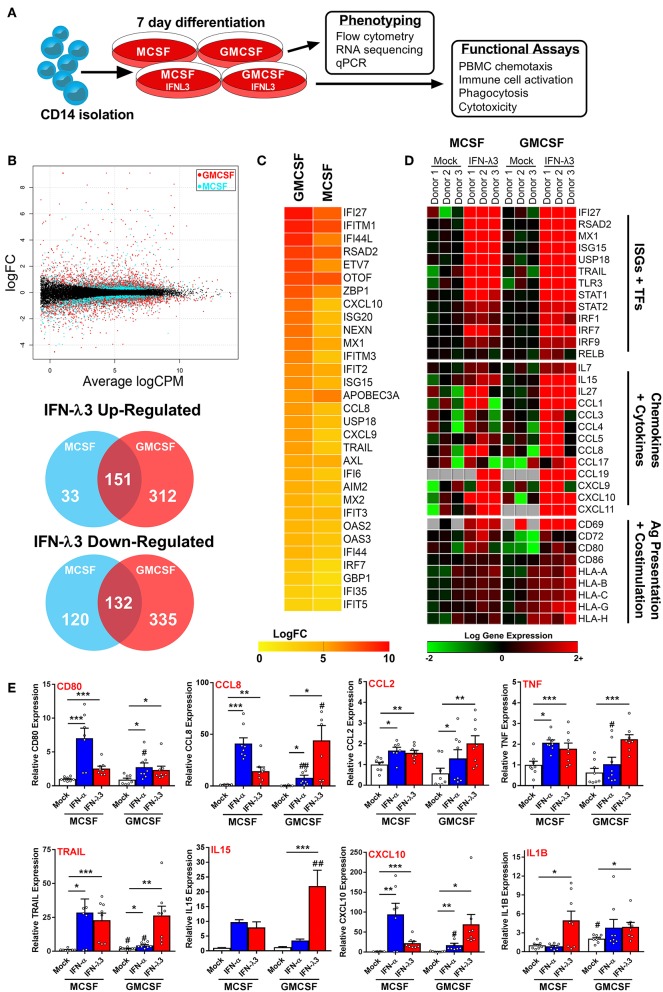
Monocyte differentiation with IFN-λ3 drives a pro-inflammatory macrophage phenotype. Monocytes were cultured with M- or GM-CSF ± IFN-λ3 for 7 days to examine the effect of IFN-λ3 on Mϕ differentiation, followed by phenotypic and functional characterization (A). RNA sequencing (n = 3/treatment) demonstrated that GM-CSF Mϕs were significantly more responsive to IFN-λ3, as demonstrated by smear plot and Venn diagram of genes regulated above 2-fold (B). GM-CSF Mϕ ISG induction was significantly stronger, as demonstrated by heat map of gene log 2-fold change (logFC) (C). IFN-λ3 increased transcript abundance of numerous ISGs and transcription factors (TFs) in both Mϕ sets, as well as numerous chemokines, cytokines, and genes responsible for antigen (Ag) presentation and co-stimulation, particularly in GM-CSF Mϕs (D). IFN-λ3 stimulated genes were confirmed by qPCR, using IFN-α differentiated Mϕs as a comparison (E) (n = 8). Quantitative PCR data are representative of three independent experiments. Paired t-test */#p < 0.05, **/##p < 0.01, ***p < 0.001 (mean ± SE). *Mock vs. IFN treatments, #M-Mϕ vs. GM-Mϕ.